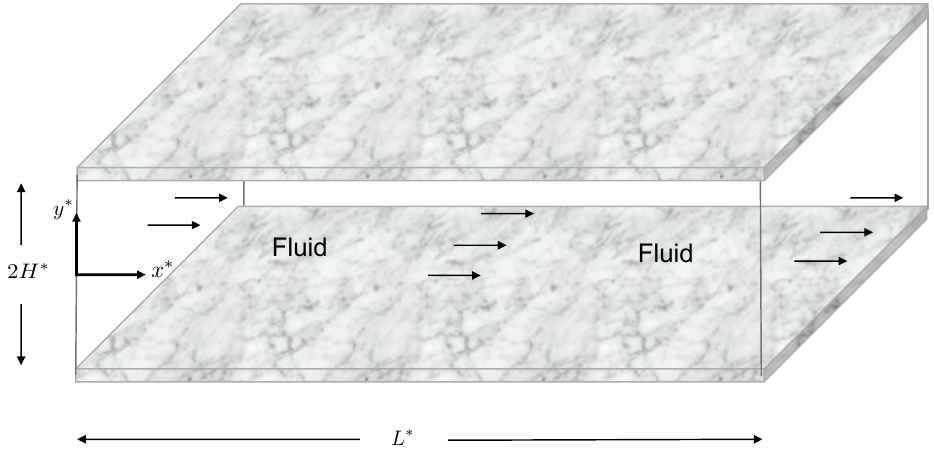
Figure 1. Sketch of the